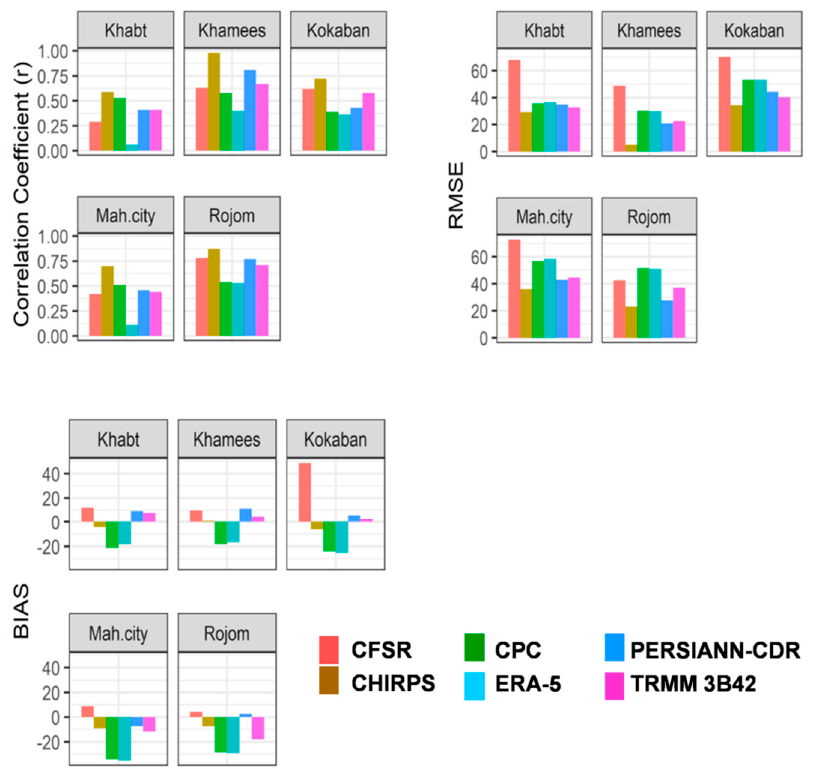
Figure 3. Summary of monthly correlation coe ffi cient (r), root-mean-square error (RMSE, mm), and bias (BIAS, mm) of the precipitation products compared to observations in the five areas from Al Mahwit governorate: Khabt, Khamees, Kokaban, Mahwit city, and